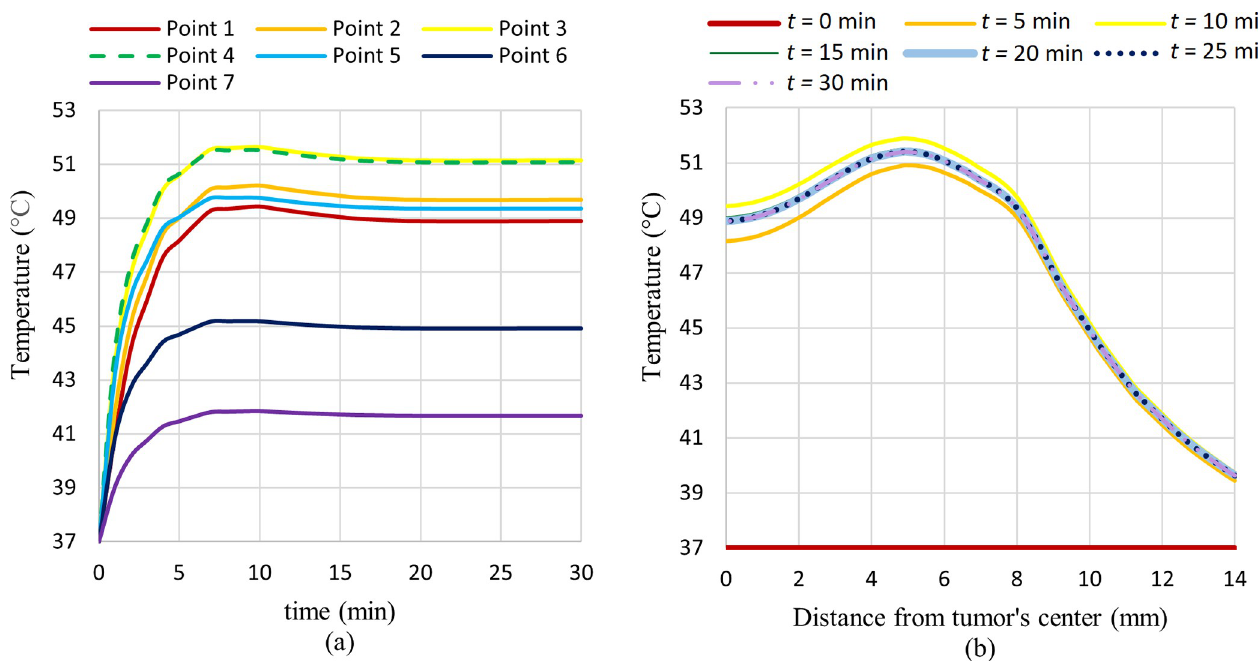
Fig 16. Temperature generated versus, (a) time at different considered points, (b) distance from tumor’s center at different